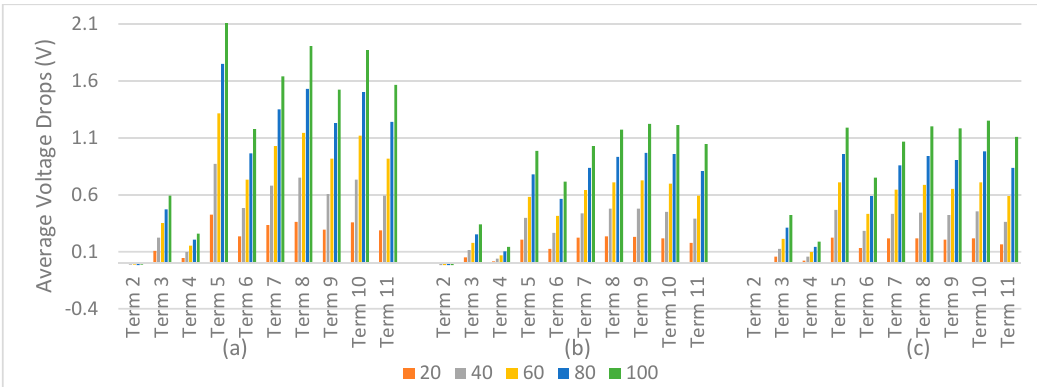
Figure 13. Worst case voltage drops (line to ground) observed—( a ) unoptimized versus, ( b ) optimized for minimizing peak voltage drops across all cables per vehicle with no limit on configuration, ( c ) optimized for minimizing peak voltage drops across all cables per vehicle with with no charging station having more than 25% of the vehicles charging at that hour.